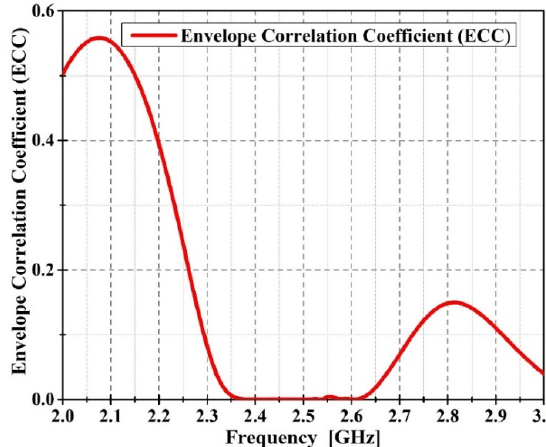
FIGURE 14. The simulated ECC of CP-MIMO fabric antenna